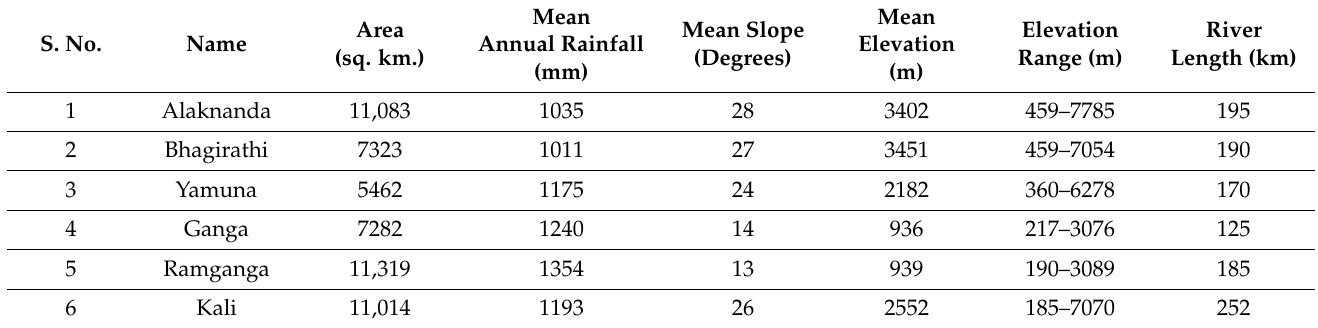
Table 1. The basic characteristics of major rivers of Uttarakhand estimated from GIS